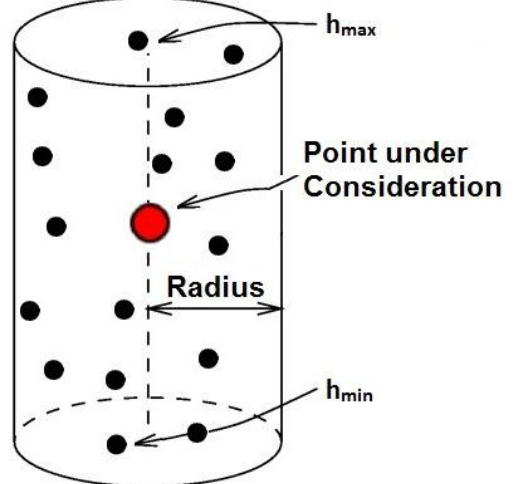
Figure 1. Vertical neighbourhood definition using a cylinder with a pre-specified radius; the height is determined by the Figure 2. Orthophoto of the benchmark site: Rue Madame, Paris, lowest and highest point. France (Courtesy: IGN-Google Maps).